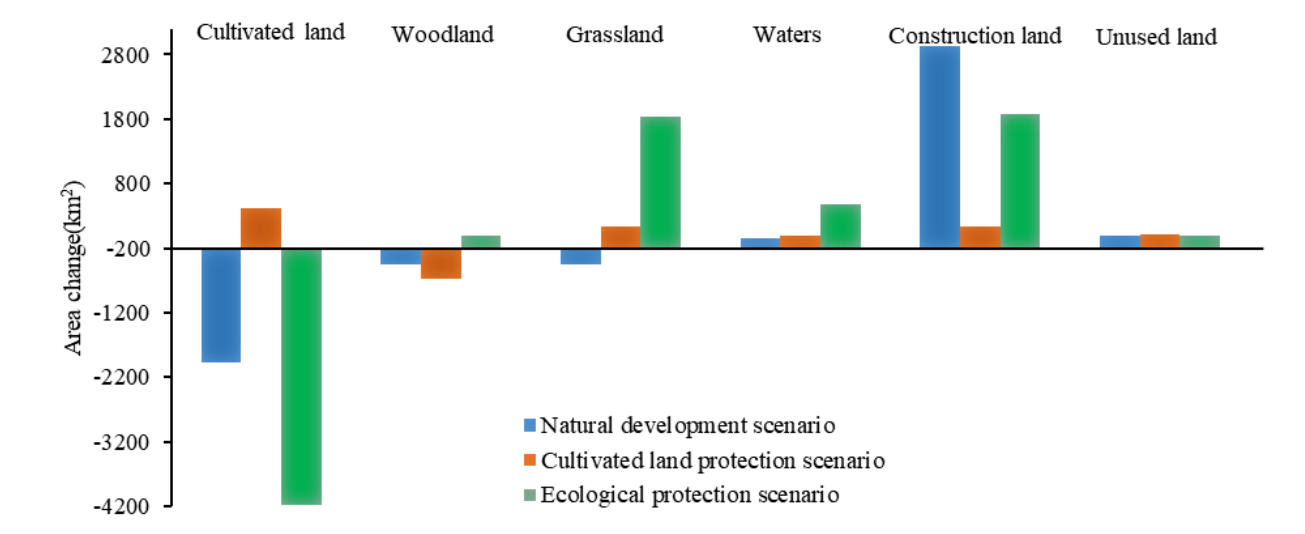
Figure 5. Comparison of land-use change scenarios from 2020 to 2035.